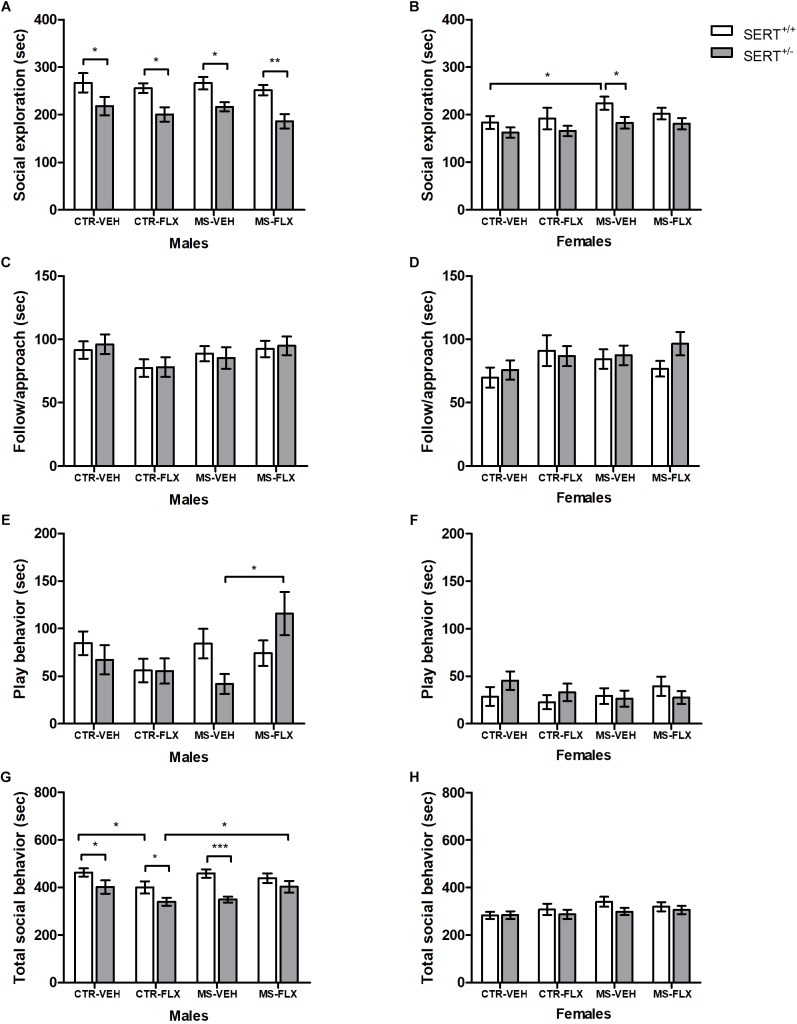
Time spent in adult social interactions such as social exploration (A,B), follow/approach (C,D), play behavior (E,F), and all social behavior combined (G,H) in male and female adult offspring exposed to fluoxetine (FLX), maternal early life stress (MS) or their combination. Figures show mean ± SEM. ∗p < 0.05, ∗∗p < 0.01, ∗∗∗p < 0.001. n = 9–13 per group (Table 1).